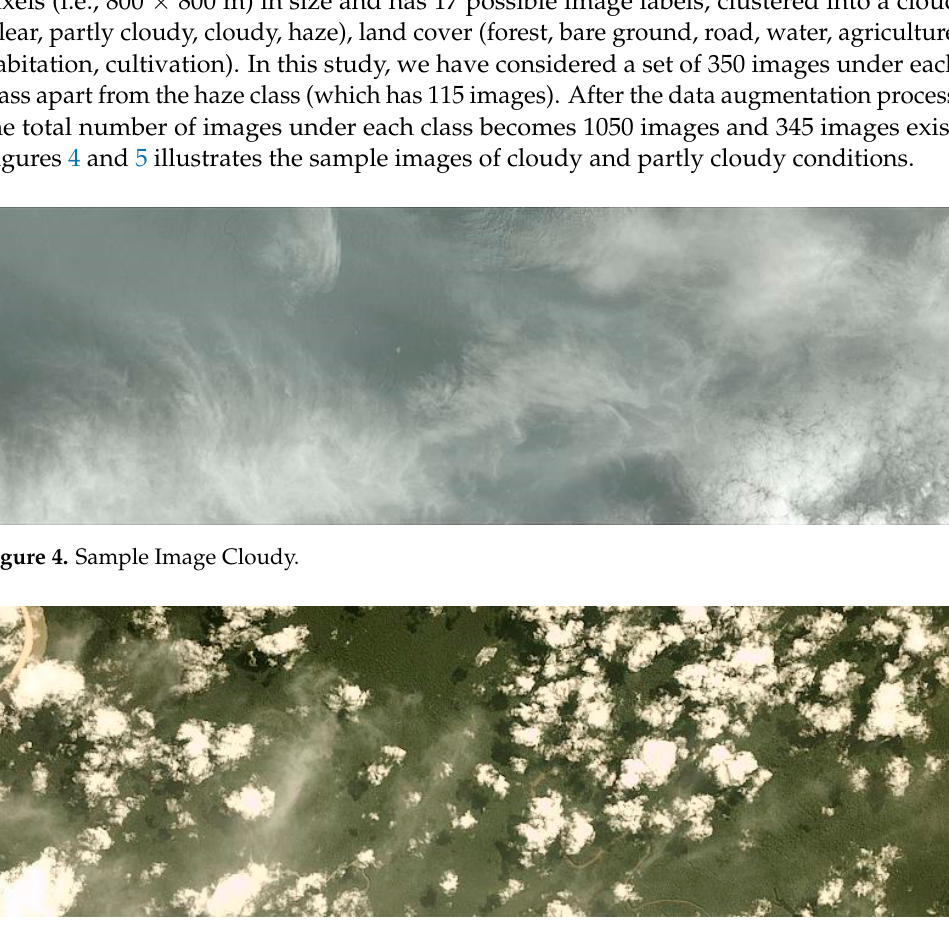
Figure 5. Sample Partly Cloudy.